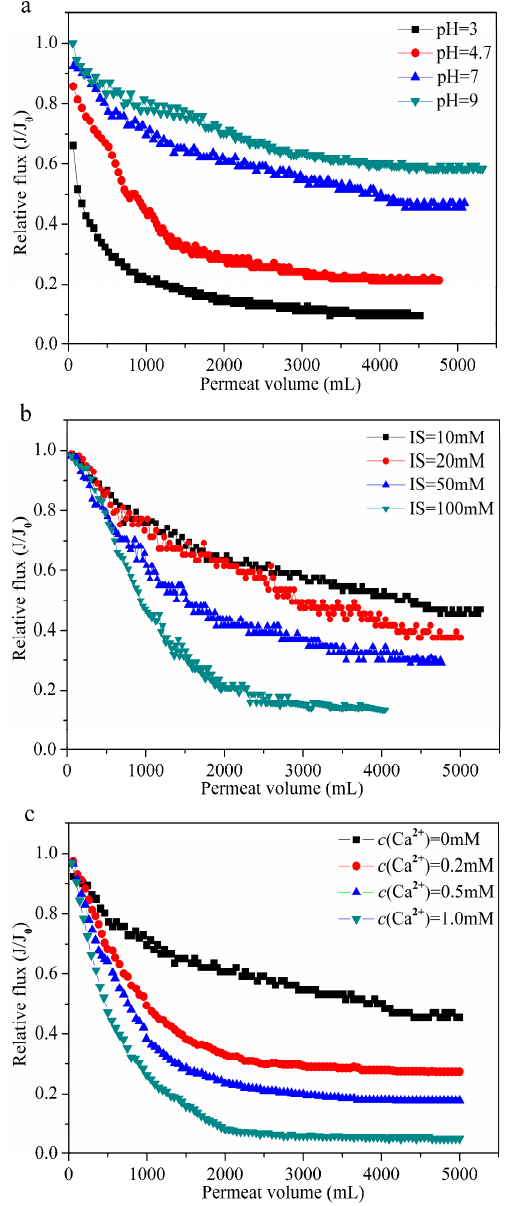
Figure 3. Normalized flux reduction curves of the humic acid (HA)–bovine serum albumin (BSA) mixtures during microfiltration (MF) at different solution conditions: ( a ) pH; ( b ) IS; ( c ) Ca 2+ concentration.